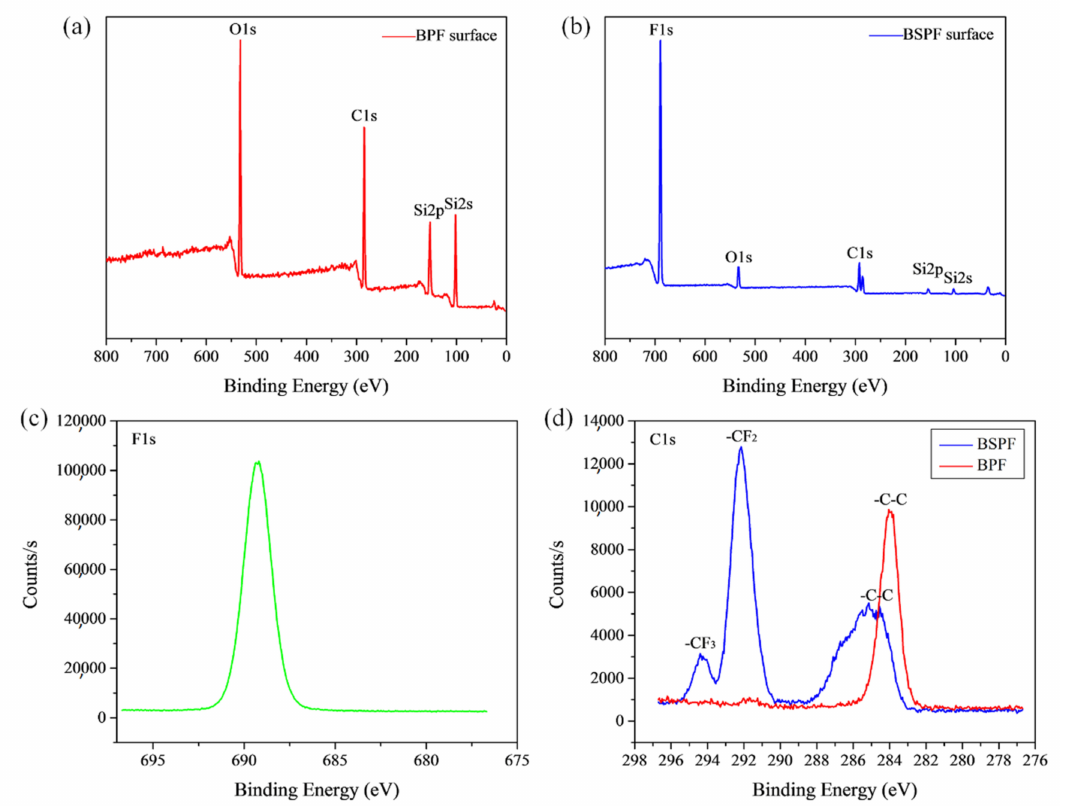
Figure 7. XPS spectrum results of ( a ) the analysis of BPF surface; ( b ) the analysis of BSPF surface; ( c ) the high-resolution F 1s peak of BSPF surface; ( d ) the high-resolution C 1s peak of BPF (red) and BSPF (blue)